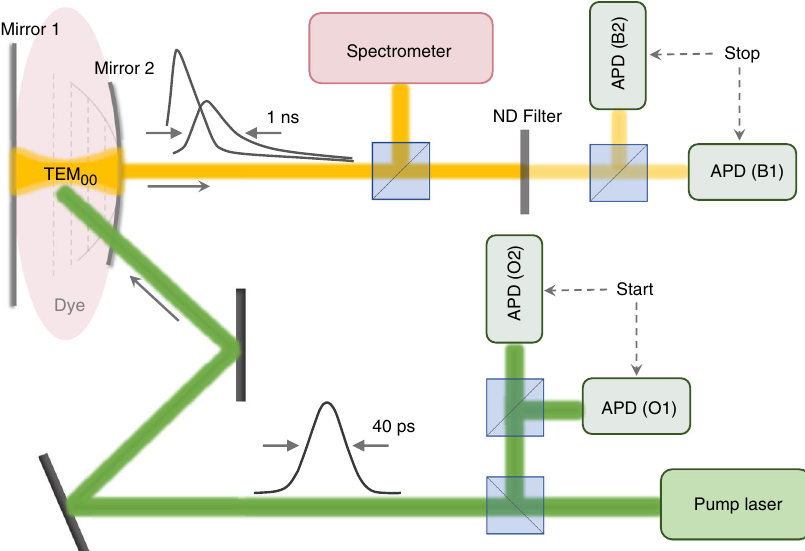
Fig. 1 Schematic representation of the experimental setup. The dye- fi lled microcavity is composed of one planar (1) and one spherical (2) mirror. The pulsed pump (green) is transmitted through the cavity at an angle of ~52°. The transverse ground-state mode (yellow) leaks through one of the mirrors and is directed both into a spectrometer and a pair of single-photon detectors, B1 and B2, in a Hanbury Brown – Twiss arrangement. A second pair of detectors, O1 and O2, is used to time the beginning of the experiment.